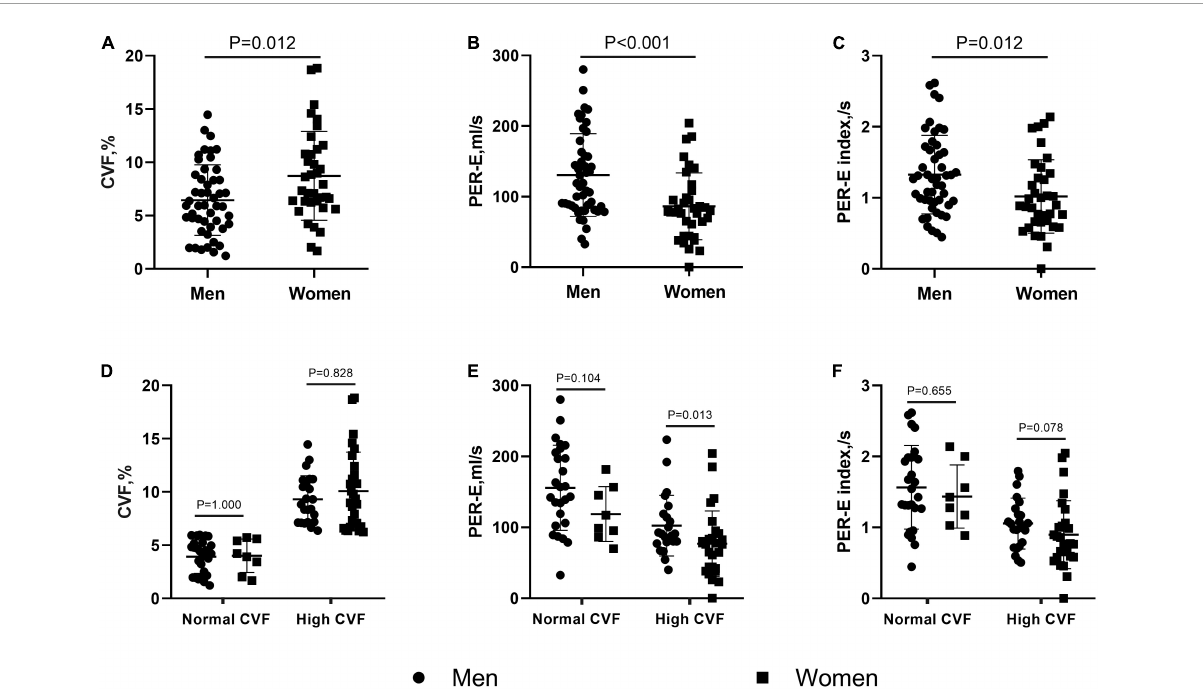
FIGURE2 Sex differences in collagen volume fraction (CVF) and left atrial (LA) deformation rates in patients with hypertrophic obstructive cardiomyopathy (HOCM). Female patients showed higher CVF (A) , but lower peak of emptying rate (PER-E) (B) , and PER-E index (C) than males. When stratifying patients by the CVF values, the sex differences in CVF (D) and PER-E index (F) were eliminated in the subgroups with normal and high CVF, but in PER-E (E) , the sex differences remained significant in the subgroup with high CVF.